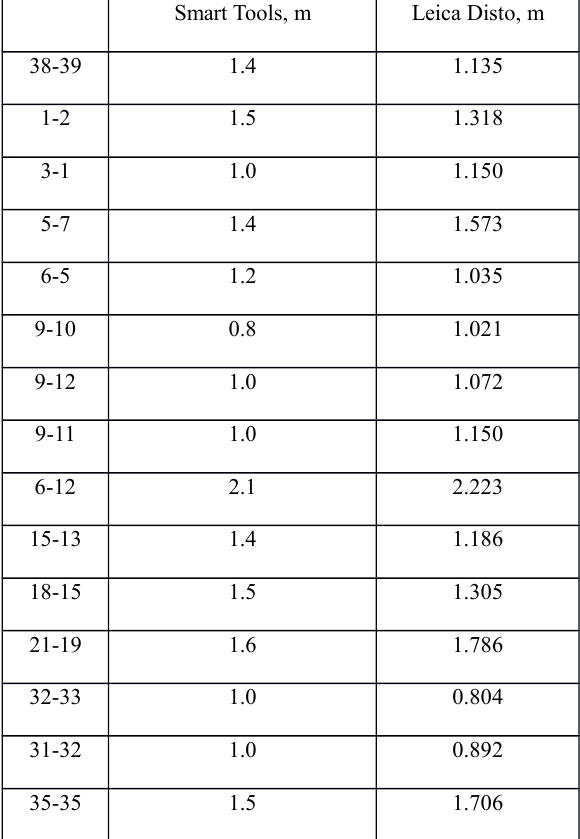
Table 1. Results of control distances